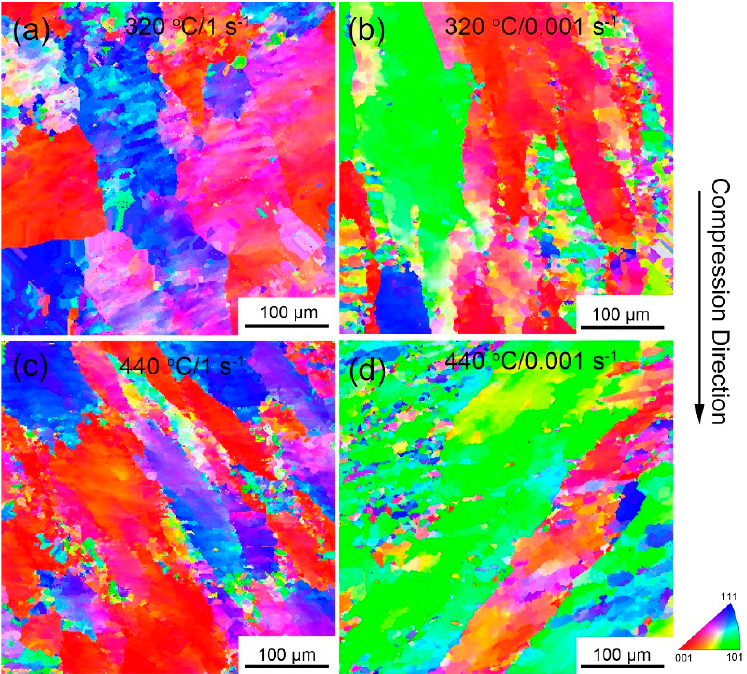
Figure 11. EBSD IPF images of compressed samples: ( a )320 °C/1 s − 1 ; ( b ) 320 °C/0.001 s − 1 ; ( c ) 440 °C/1 s − 1 ; ( d ) 440 °C/0.001 s − 1 .